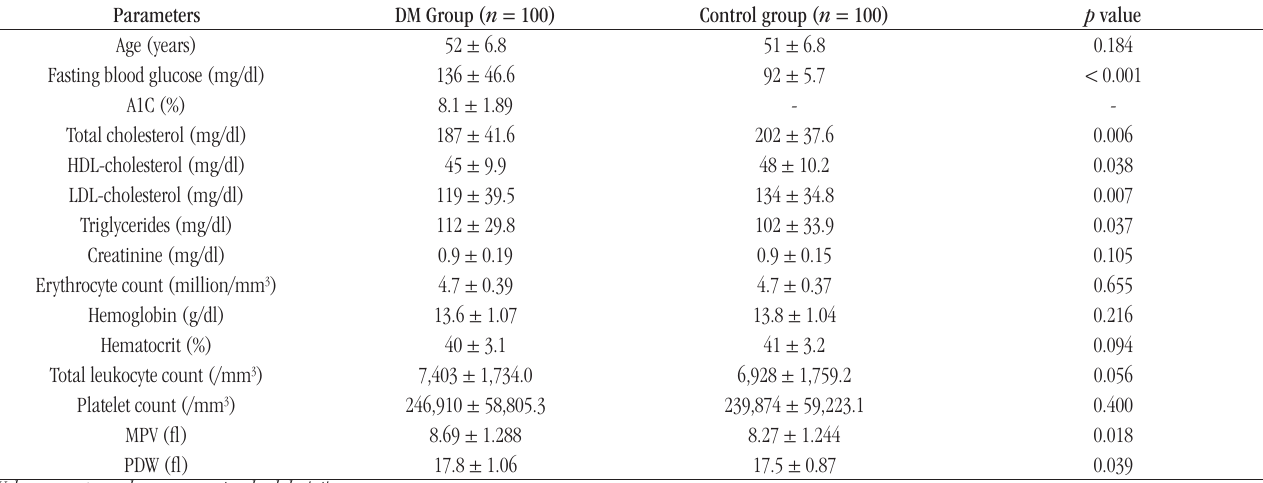
taBLE 1 – Biochemical and hematological analysis of the studied subjects